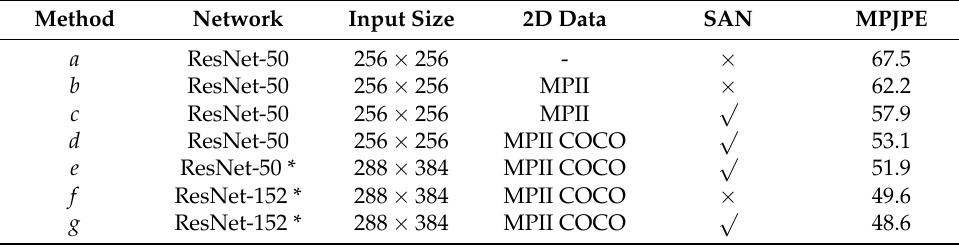
Table 1. Ablative study on Human3.6M. Mean per joint position error (MPJPE) numbers are in mm.